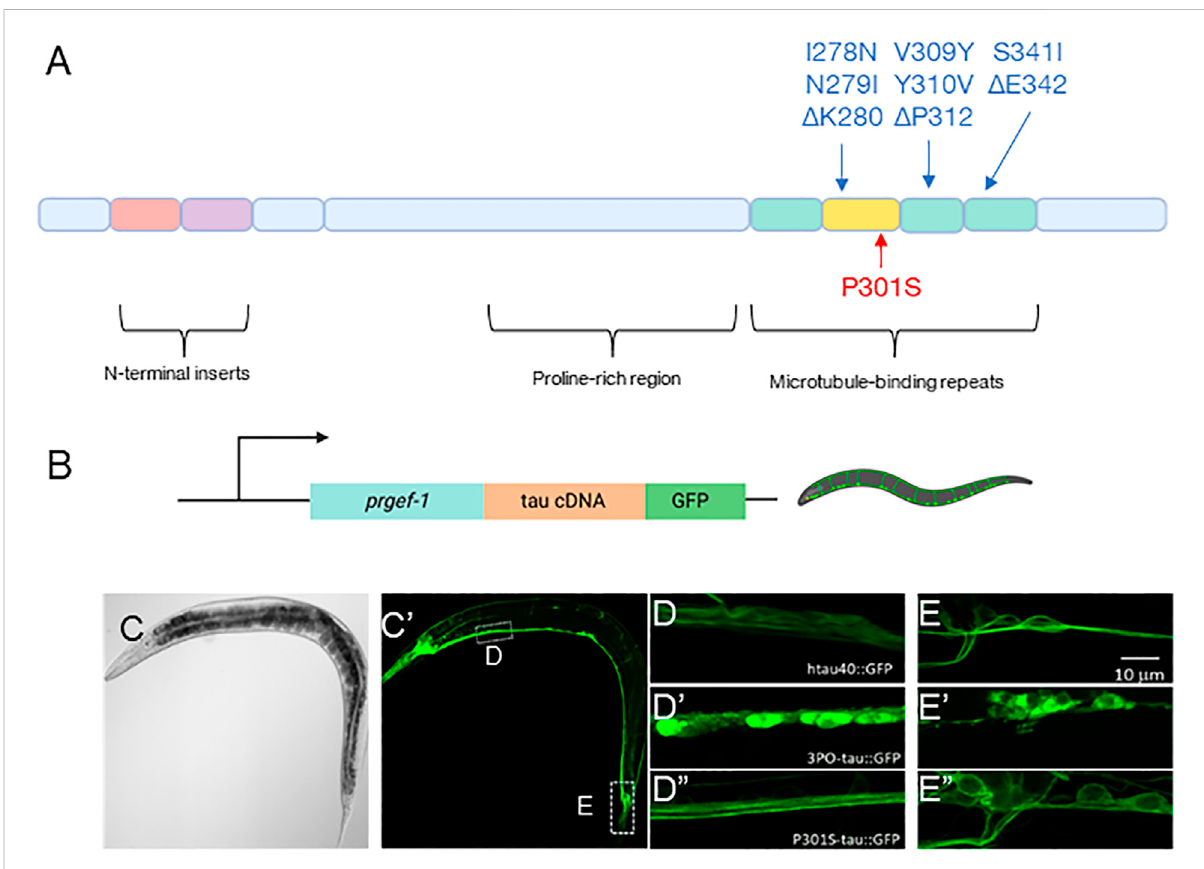
FIGURE 1 Pan-neuronal model of tau aggregation. (A) Schematic representation of the 2N4R tau isoform (hTau40) and the mutations used in this report. (B) A schematic representation of the DNA constructs injected (created with BioRender.com). (C) A transmitted light and (C 9 ) fl uorescent image of a day one adult animal expressing hTau40GFP. Magni fi ed confocal images of the (D) ventral nerve cord and (E) tail regions of the animals in the wild- type hTau40, 3PO (D ’ ,E ’ ) and P301S (D ” , E ” ) expressing animals. Note, the images are taken from regions indicated by the hashed boxes in (C) . (D) Wefound that in theventral nerve hTau40was evenly concentratedthroughout axons, in contrast to (D 9 ) 3POtau whichwasconcentrated inthe cell bodies. (D ” ) P301S was similar to the wild-type tau. (E,E ’ ,E ” ) In the tail we observed similar results, with tau present through the cell